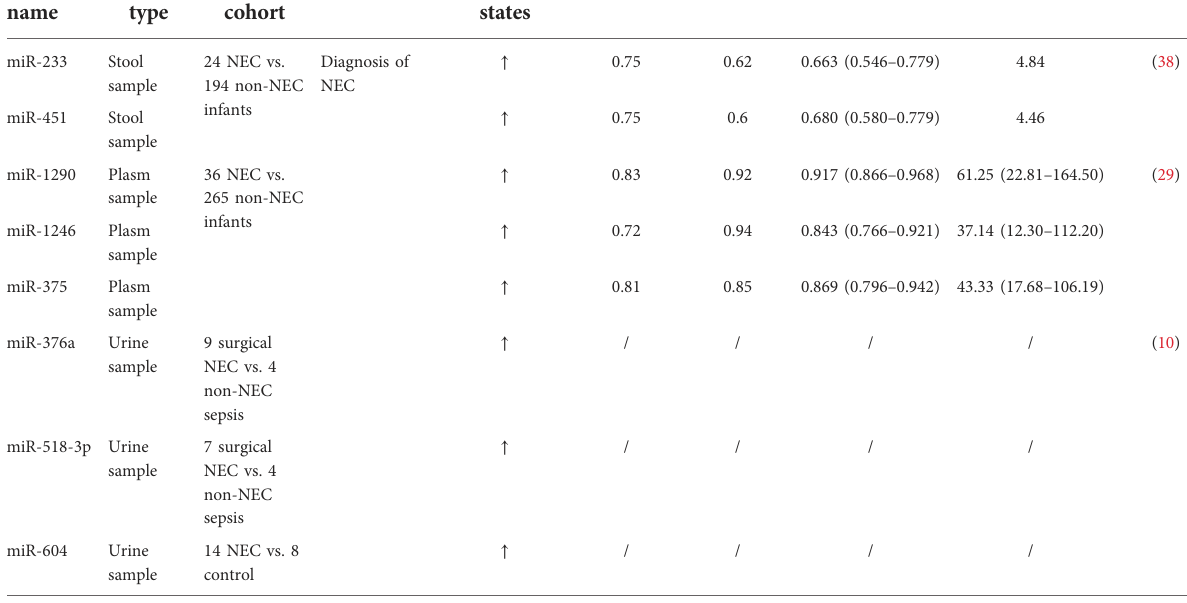
TABLE 2 miRNAs levels as biomarkers for diagnosis of NEC patients in different